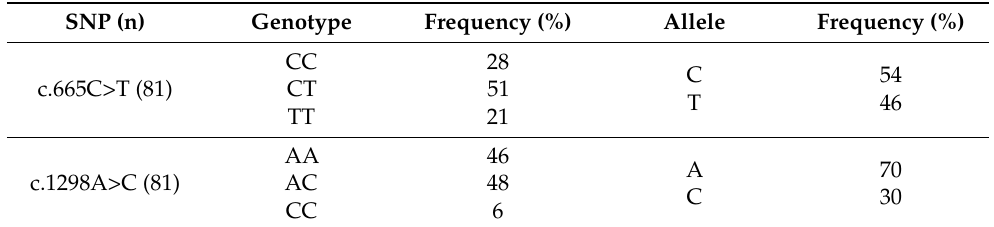
Table 2. MTHFR c.665C>T and c.1298A>C genotype frequencies of the patients included in the